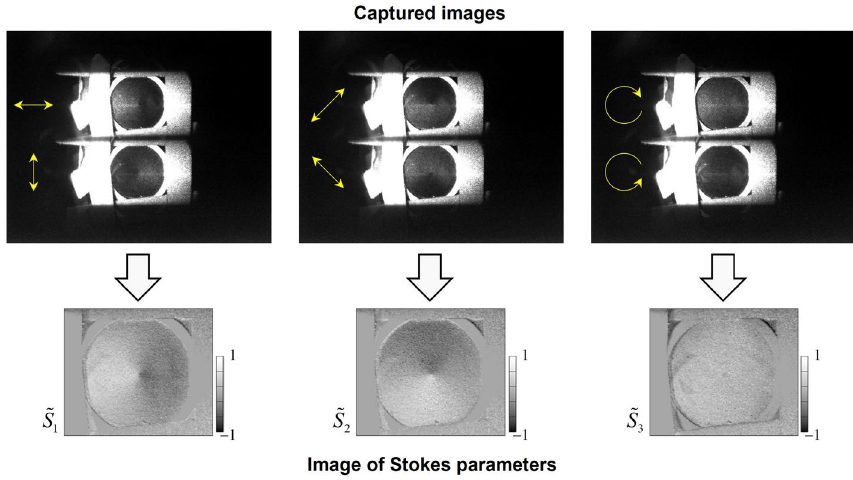
Figure 4. Captured images and reconstructed Stokes parameters of the patterned retarder where the sample was illuminated with RCP